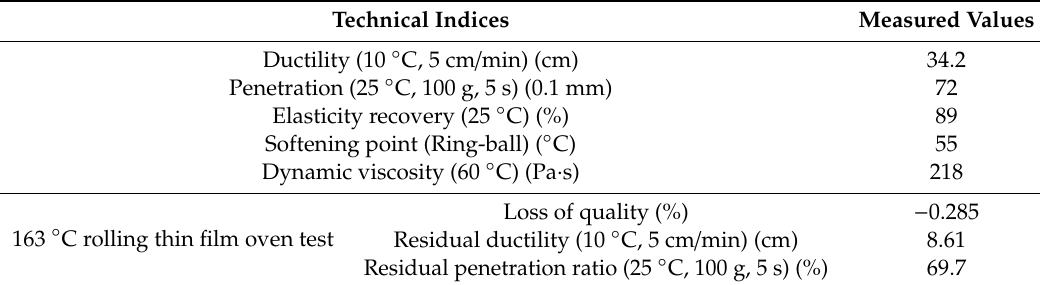
Table 1. Main properties of the asphalt matrix (AM).